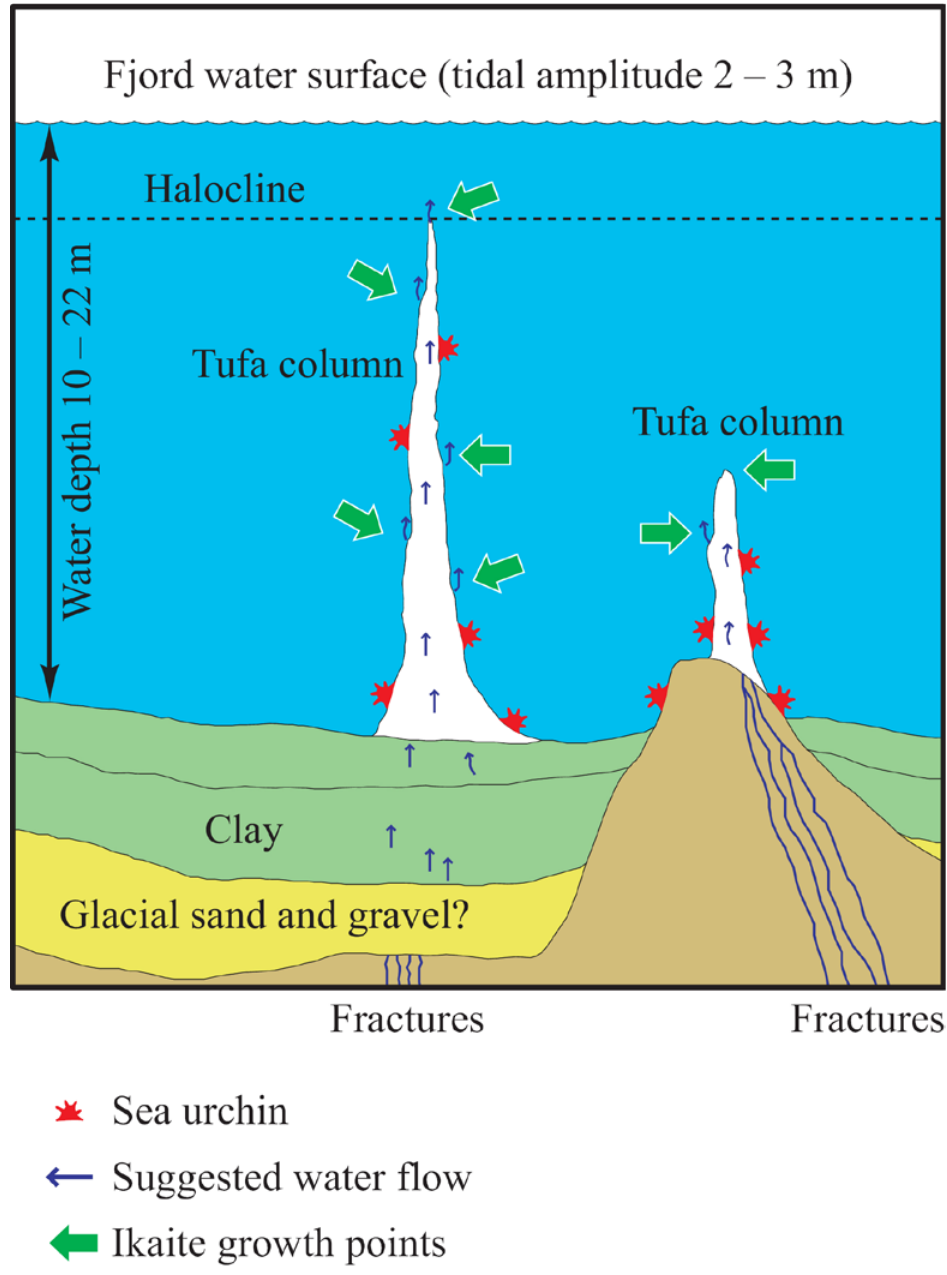
Figure 3. Proposed model for the formation of tufa columns over submarine springs in Ikka Fjord.